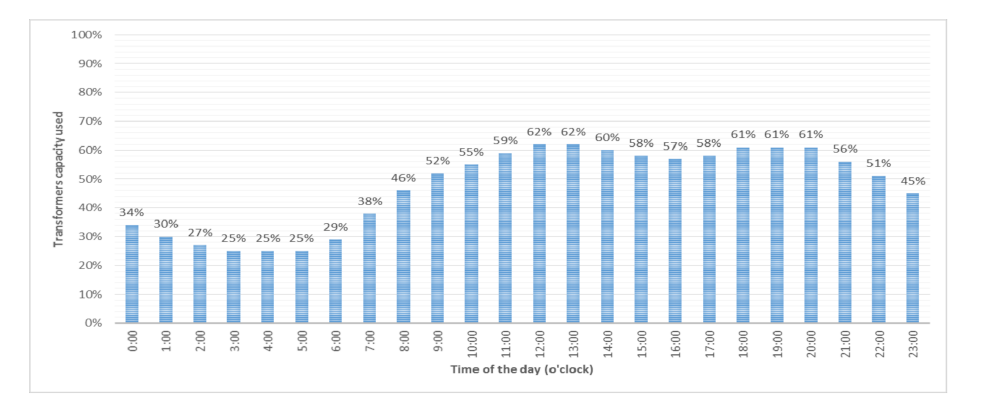
Figure 9. Transformer capacity usage without considering PEV